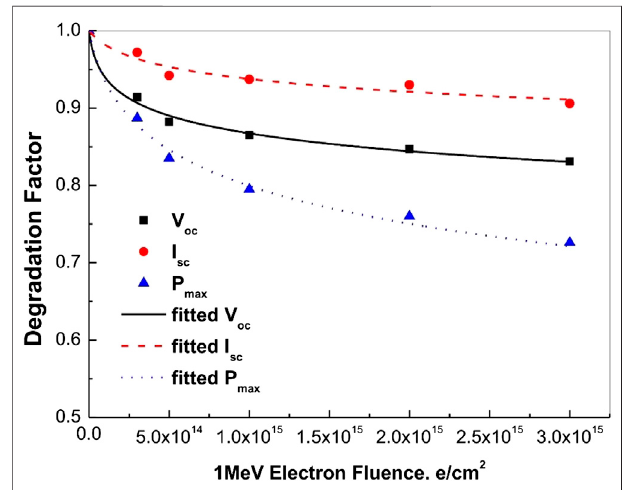
FIGURE 7 | The degradation of electrical parameters of GaInP/GaAs/ InGaAs solar cell under 1 MeV electron irradiation with different particle fl uence